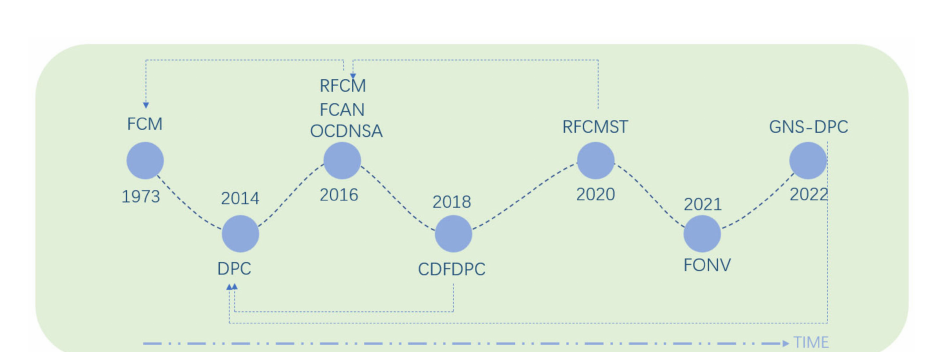
Figure 5. Main algorithms and proposed time of fuzzy set theory in complex network